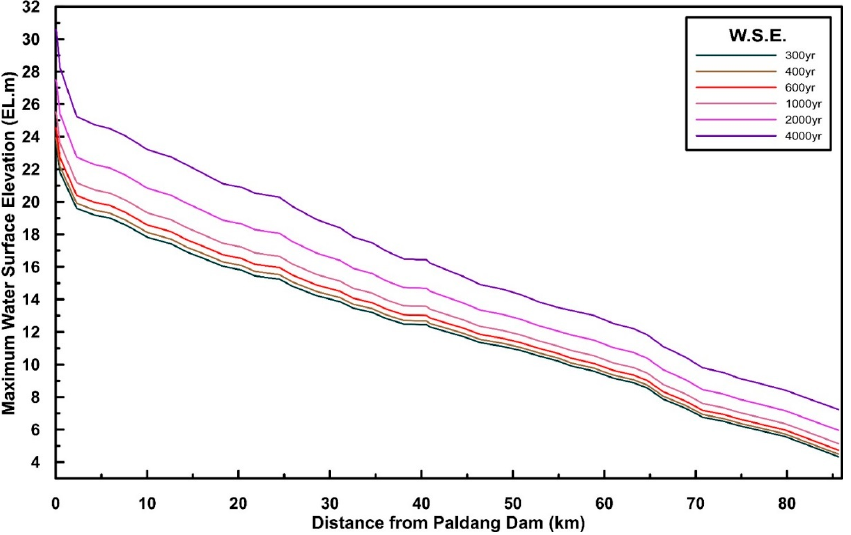
Figure 10. Estimated max water surface elevation.